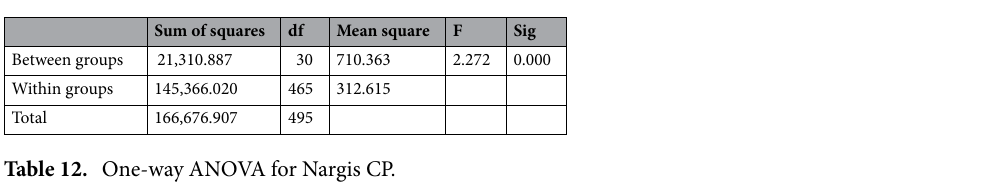
Table 12. One-way ANOVA for Nargis CP.